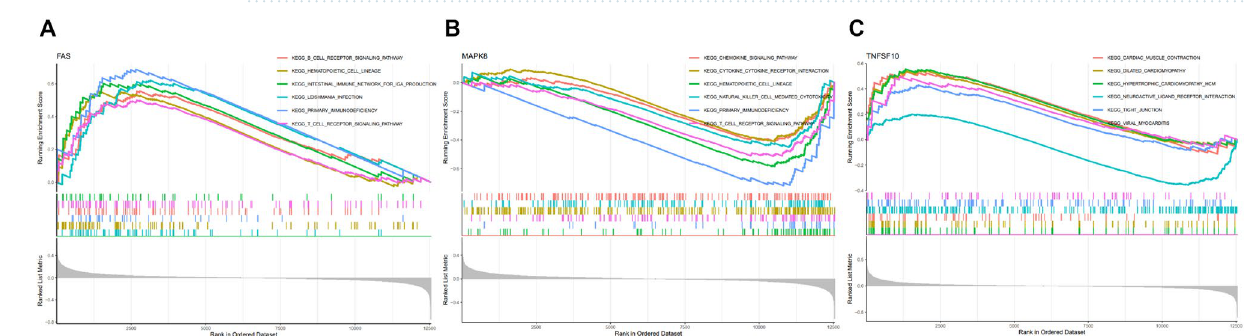
Figure 4. Single-gene GSEA-KEGG pathway analysis of FAS ( A ), MAPK8 ( B ) and TNFSF10 ( C